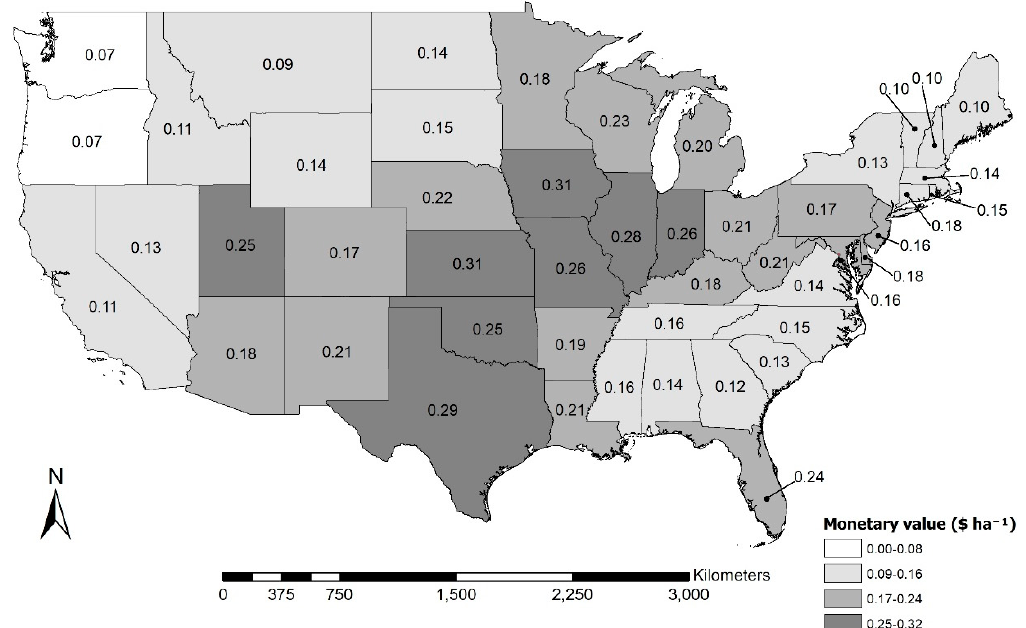
Figure 4. Average annual monetary values normalized by land area ($ m − 2 ) of non-constrained potential soil inorganic carbon (SIC) sequestration from combined atmospheric Ca 2+ and Mg 2+ deposition (2000–2015) for different states in the contiguous United States (U.S.) based on an avoided SC-CO 2 of $42 per metric ton of CO 2 [16].